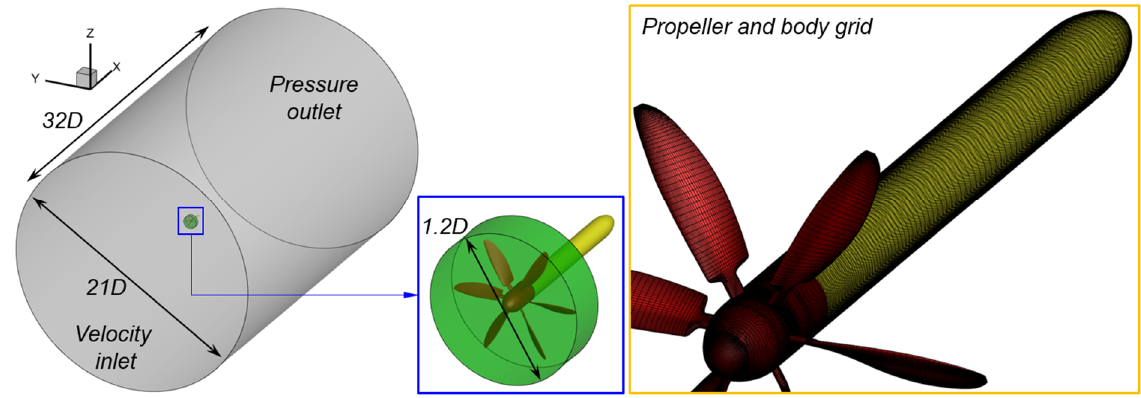
Figure 5. CFD grid for the prediction of the propeller’s aerodynamic performance.